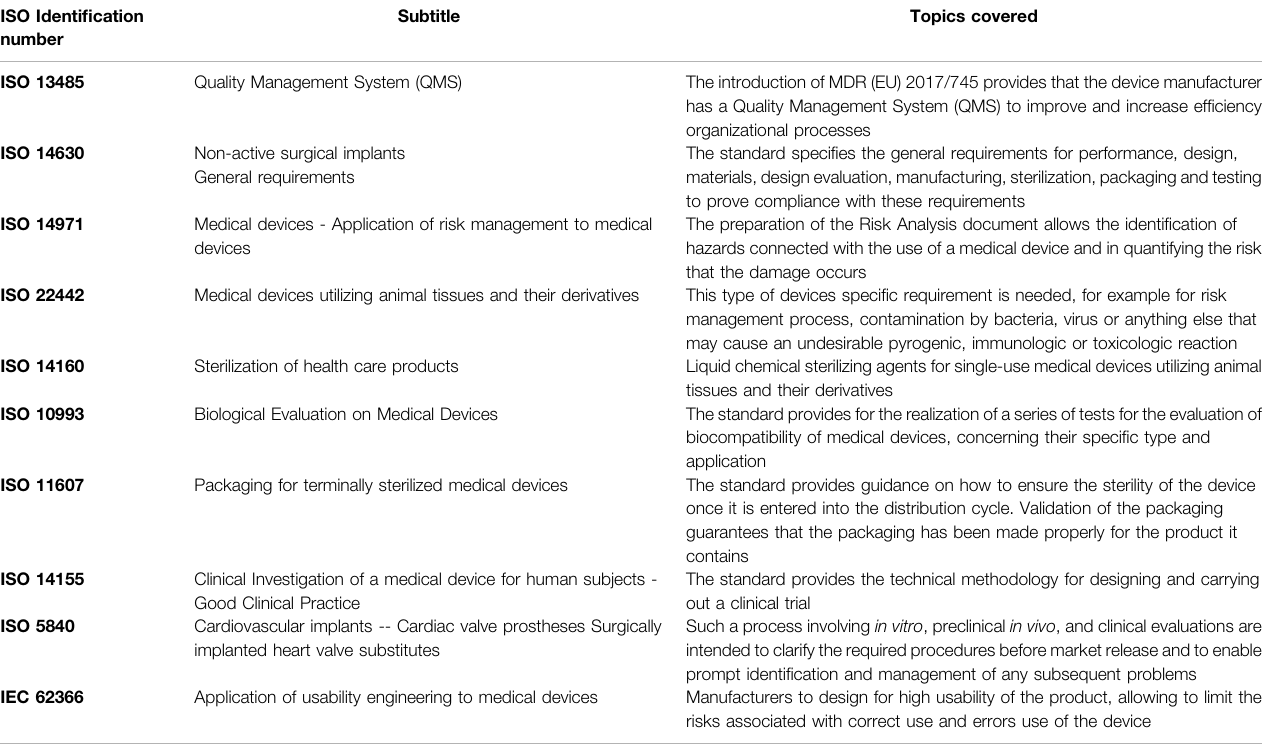
TABLE 3 | Common reference ISO Standard for the production of class III implantable biological medical devices. ISO Identi fi cation